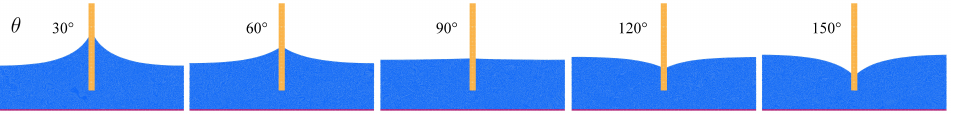
Figure 11. Final states of wetting of a vertical plate for varied numerical contact angle parameter θ